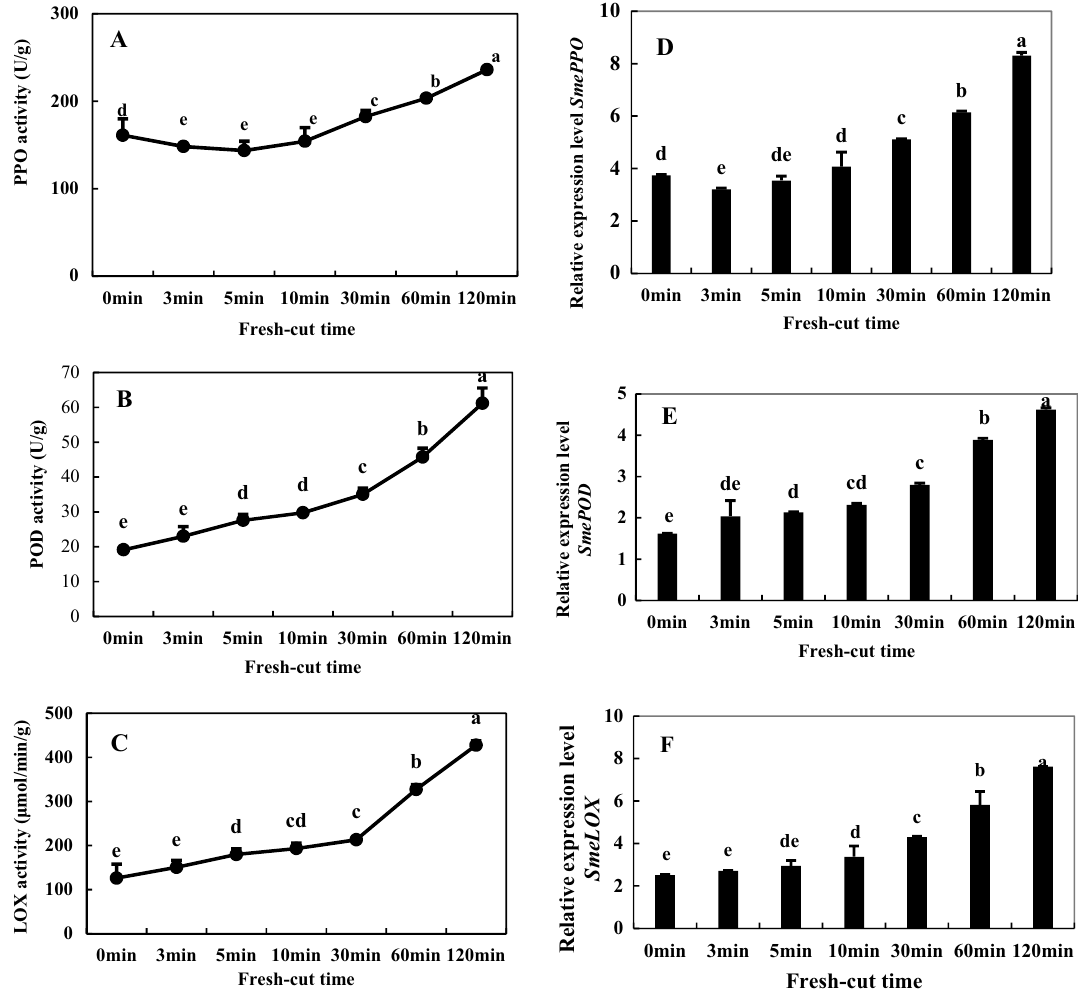
Figure 9. Activities of polyphenol oxidase (PPO) ( A ), peroxidase (POD) ( B ), and lipoxygenase (LOX) ( C ) and gene expression levels of SmePPO ( D ), SmePOD ( E ), and SmeLOX ( F ) of fresh-cut eggplant. Data represent the means of three replicates and their standard